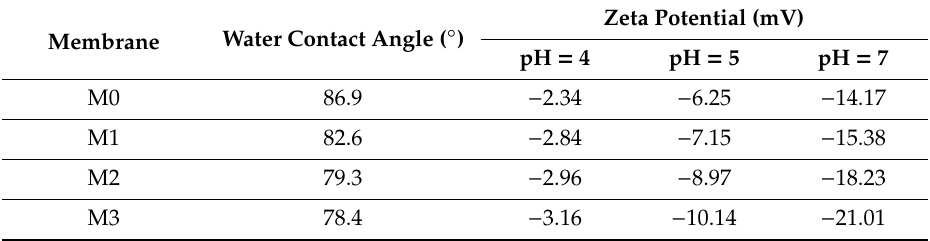
Figure 6. Thermogravimetric analysis (TGA) of the neat and MXene-incorporated membranes. Table 3. Water contact angle and zeta potential of all the prepared membranes.